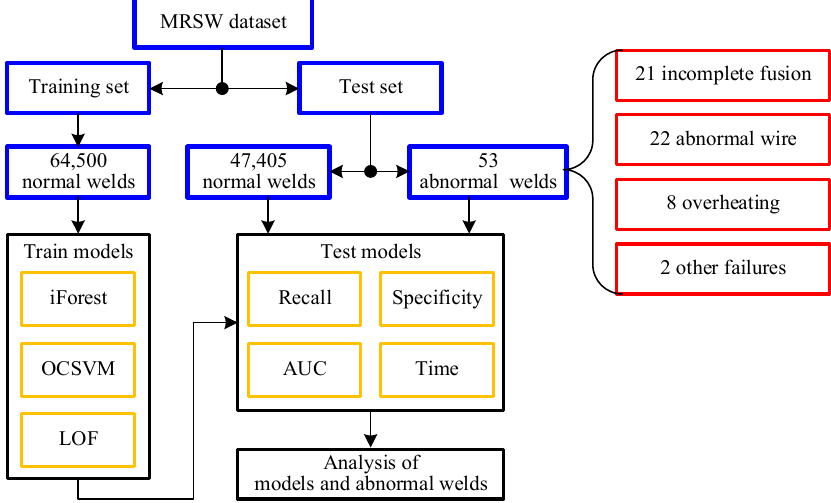
Figure 7. Model construction process.